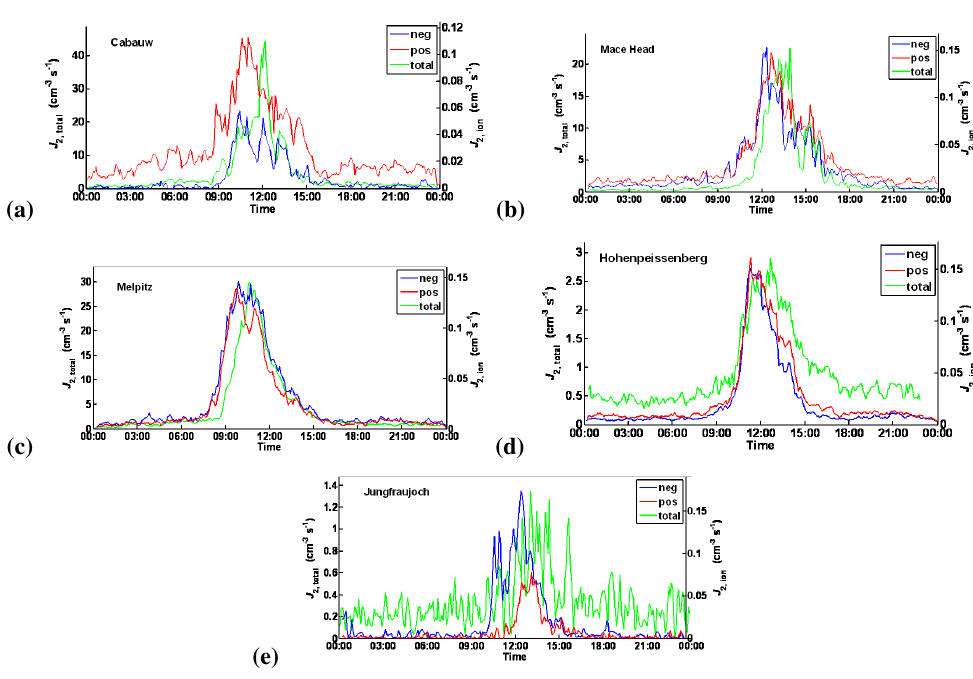
Fig. 9. Comparison of median charged and total particle formation rates during NPF events on 2008–2009 in (a) Cabauw, (b) Mace Head, (c) Melpitz, (d) Hohenpeissenberg, and (e) Jungfraujoch. Charged formation rates are measured with a (N)AIS in ion mode (negative ions, blue line and positive ions, red line). Uncharged formation rates are measured with a NAIS in particle mode (total particles, green line).